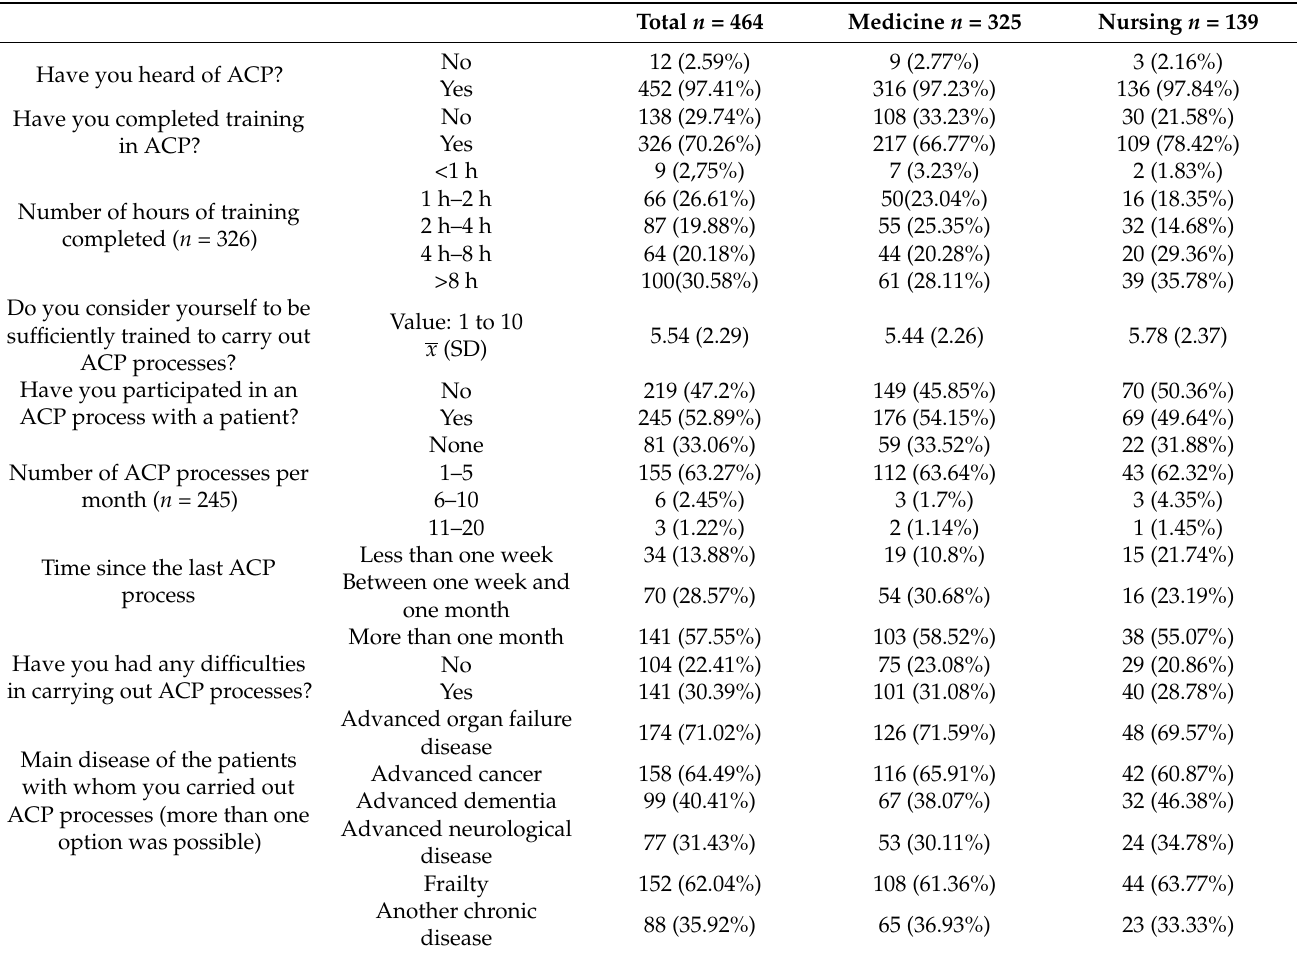
Table 2. Training and professional experience in ACP 1 according to